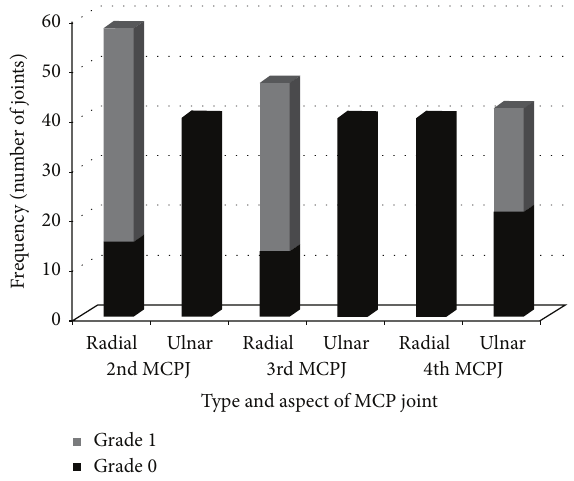
Figure 4: Distribution of grades of synovitis in the radial and ulnar sides of the 2nd, 3rd, and 4th MCPJ of both hands in the healthy control group.